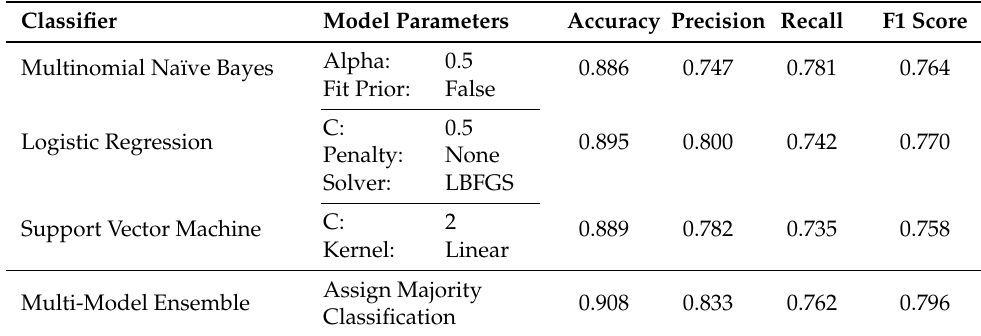
Table 2. Final model parameters and performance metrics trained on Dataset